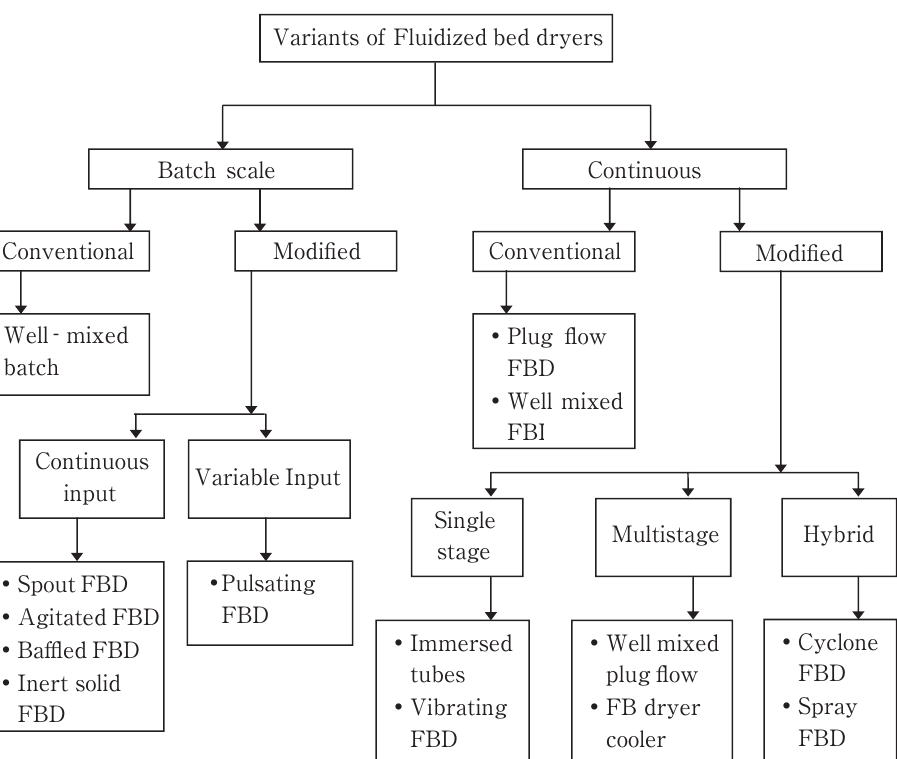
Fig. 4 Variants of fluidized bed